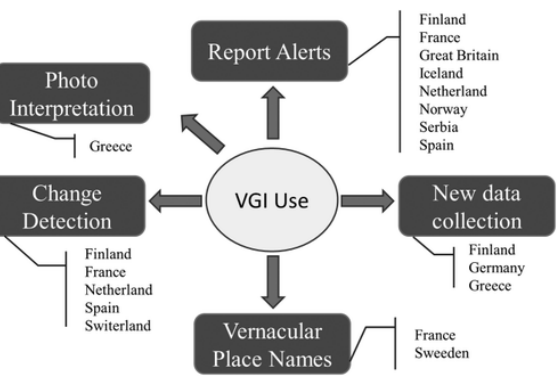
guide information 1:1000 collected by